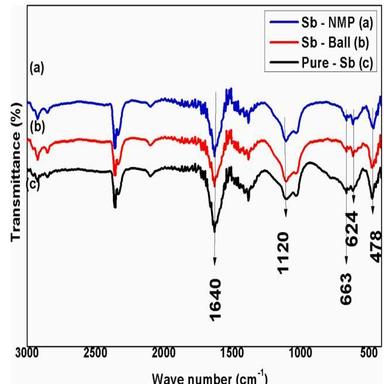
FT-IR transmittance spectrum of pure-Sb, Sb-Ball mill, Sb-NMP.